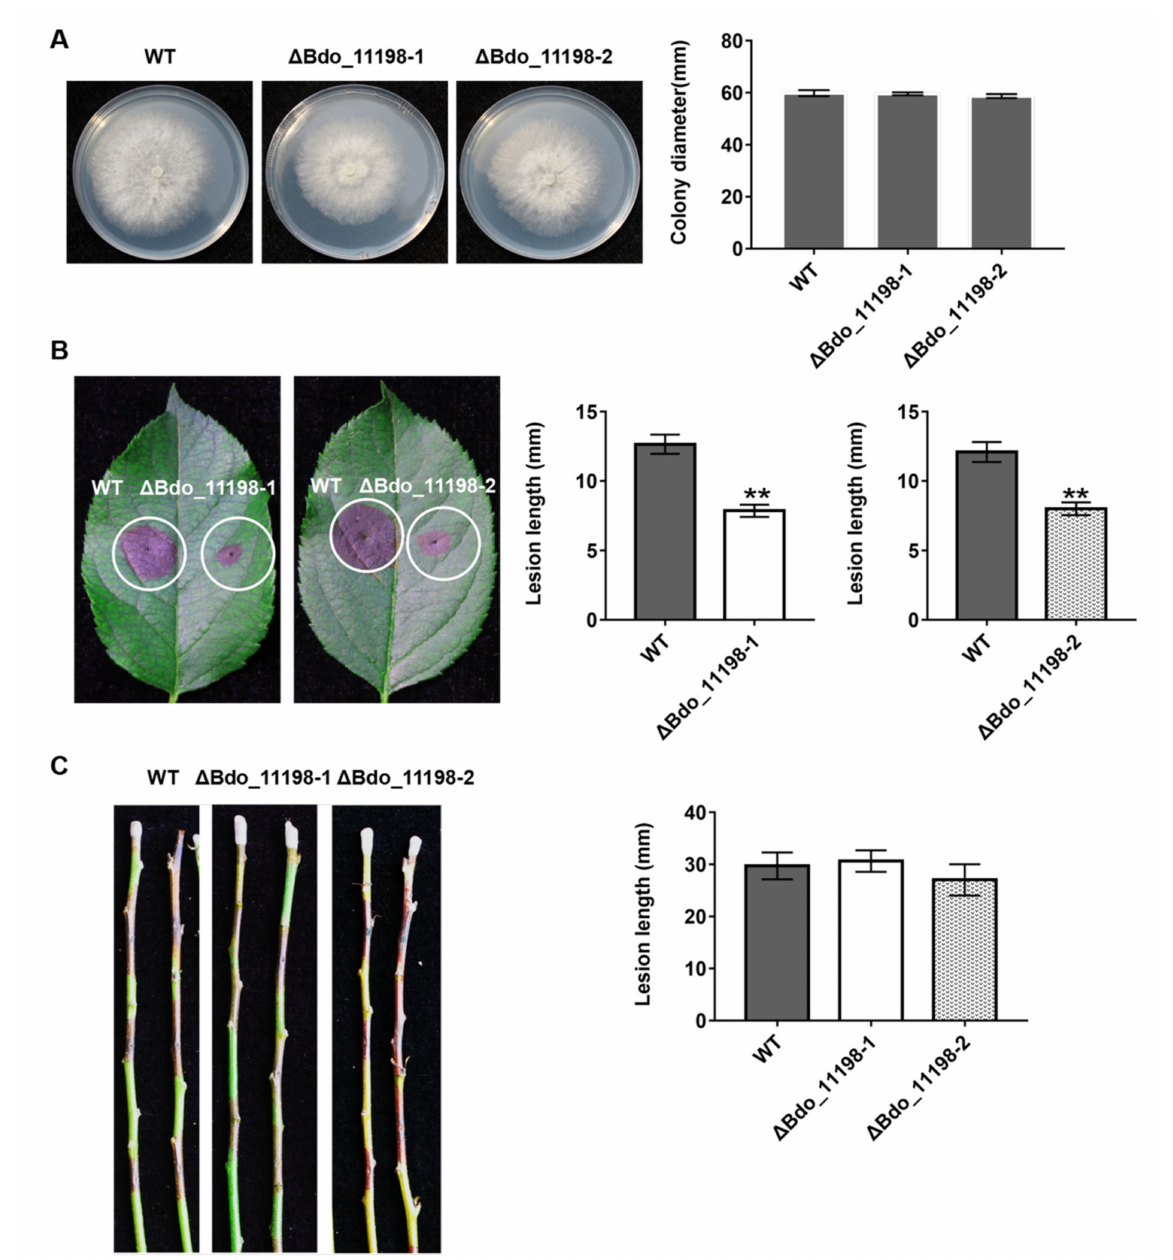
Figure 5. Functional analysis of effector Bdo_11198 in B. dothidea determined by colony characteristics and pathogenicity of gene knockout transformants. ( A ) The colony diamater of Bdo_11198 knockout mutants and wild-type (WT) on potato dextrose agar (PDA). ( B ) Pathogenicity on wounded apple leaves and ( C ) on wounded shoots were tested by inoculating with mycelial blocks of WT and Bdo_11198 knockout mutants, respectively. The lesion size was measured and symptoms were photographed five days after inoculation. Data represent means ± standard error of mean (SEM) from two independent experiments. **: significant at p <